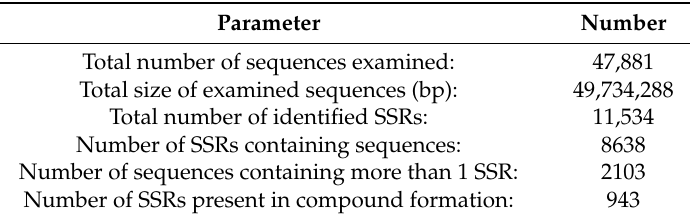
Table 2. Simple sequence repeat (SSR) marker discovery.